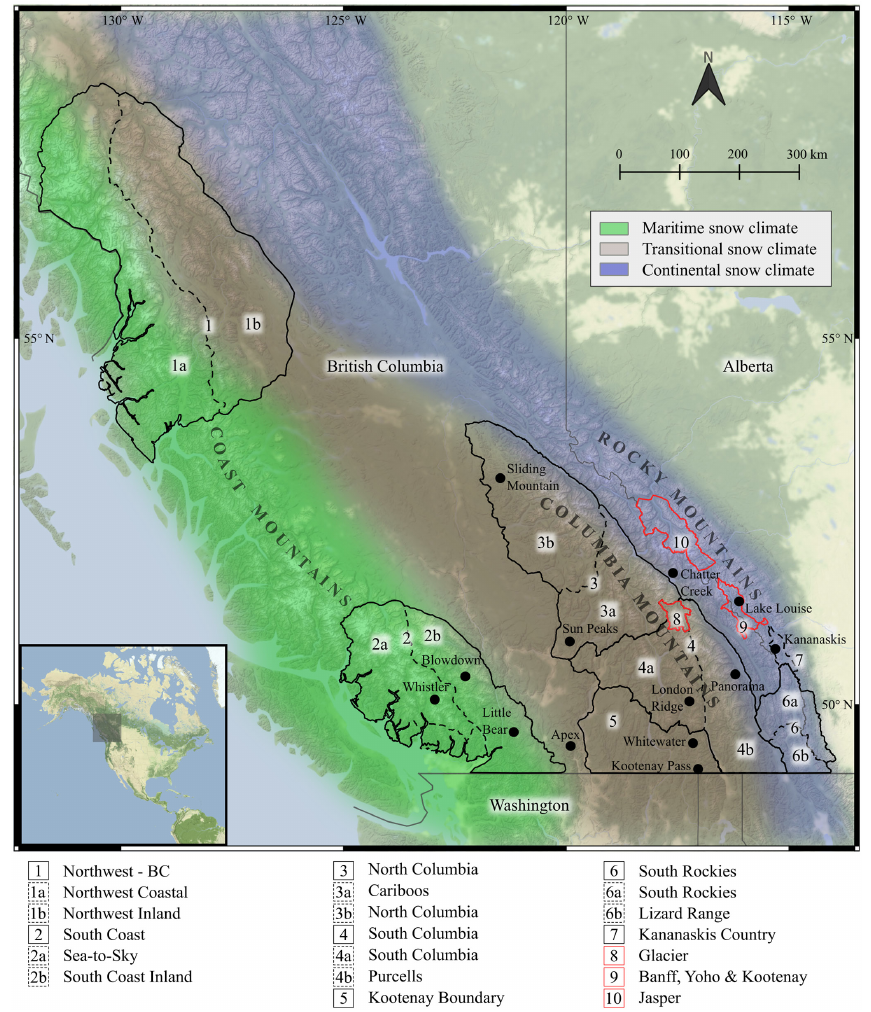
Figure 1. General mountain ranges and snow climate zones of western Canada with high-elevation weather stations’ public avalanche bulletin regions for western Canada from 2009/2010 to 2015/2016. Slight boundary modifications were made in the Sea-to-Sky region for the 2016/2017 winter. Solid black borders indicate Avalanche Canada forecast regions from 2009/2010 to 2010/2011. Dashed lines indicate Avalanche Canada’s forecast region modifications in 2011/2012, and red lines indicate Parks Canada forecast regions since 2011/2012. Background image source: Stamen Design